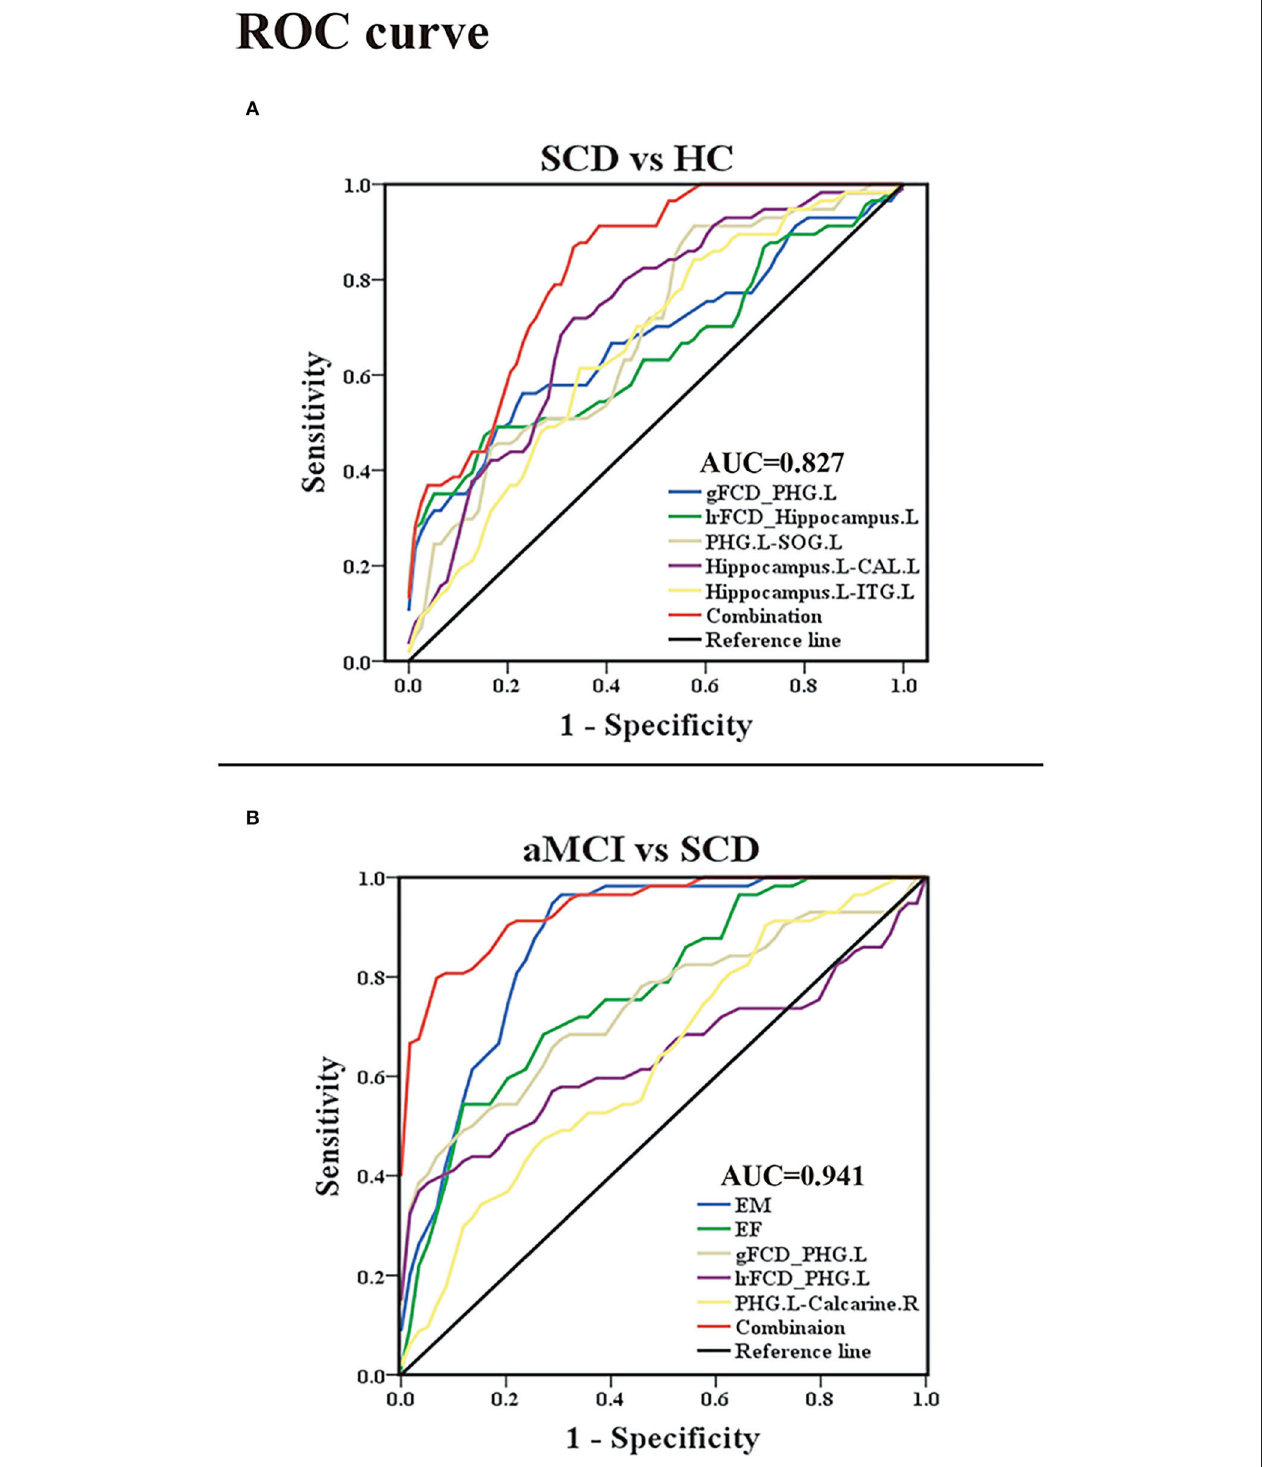
FIGURE 6 | Classification of individuals as SCD vs. HC and aMCI vs. SCD based on the ROC analysis. (A) The ROC curve presenting the classification of SCD and HC; (B) ROC curve showcasing the classification of aMCI and SCD. ROC, receiver operating characteristic; AUC, area under the ROC curve (of the combination of multiple indexes); SCD, subjective cognitive decline; aMCI, amnestic mild cognitive impairment; HC, healthy control; gFCD, global functional connectivity density; lrFCD, long-range functional connectivity density; EM, episodic memory; EF, executive function; PHG, parahippocampal gyrus; SOG, superior occipital gyrus; ITG, inferior temporal gyrus; CAL, cerebellum anterior lobe; L, left; R, right.